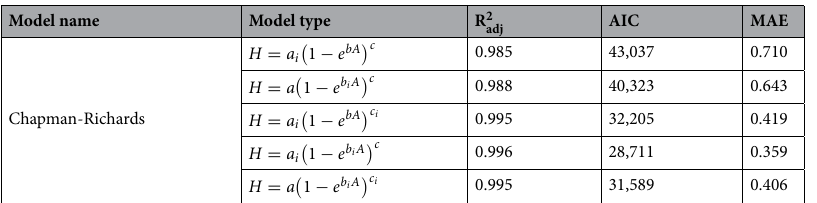
Table 3. Adjusted coefficient of determination ( R 2 adj ), the Akaike information criterion (AIC) and mean absolute error (MAE) for Chapman-Richards function with different random parameters on both: trees and natural forest regions as grouping levels (random effects are expressed with index i).